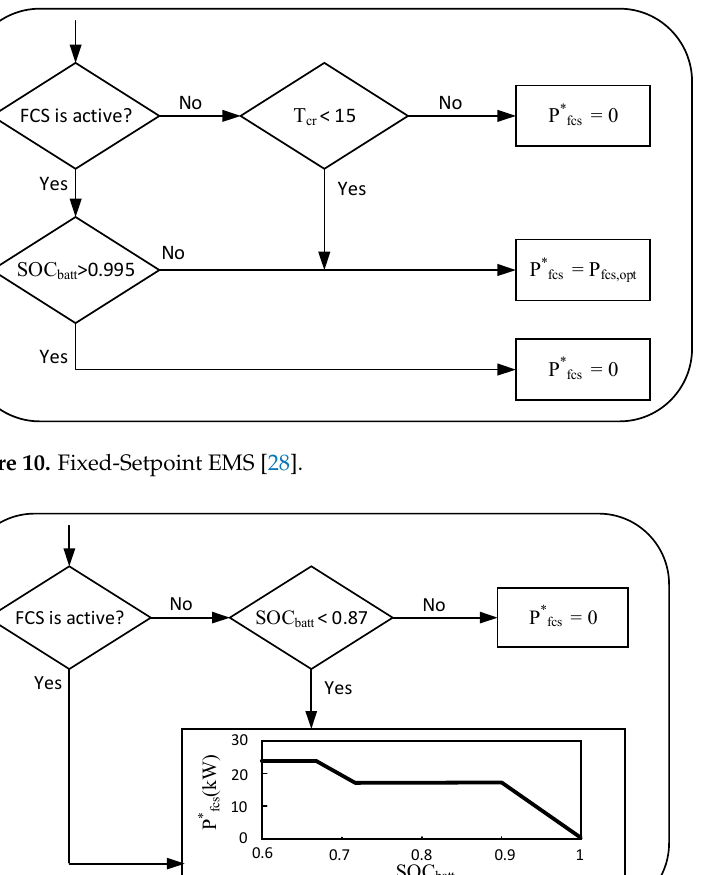
P * fcs = P fcs,ref P * fcs = 3kW Figure 12. Predictive EMS [28]. The Fixed-Setpoint EMS keeps the fuel cell operating at maximum efficiency to min- imize hydrogen consumption. On the one hand, the EMS needs to turn off the fuel cell periodically to avoid overcharging the battery; on the other hand, EMS should minimize the number of fuel cell start/stop times and extend its service life.